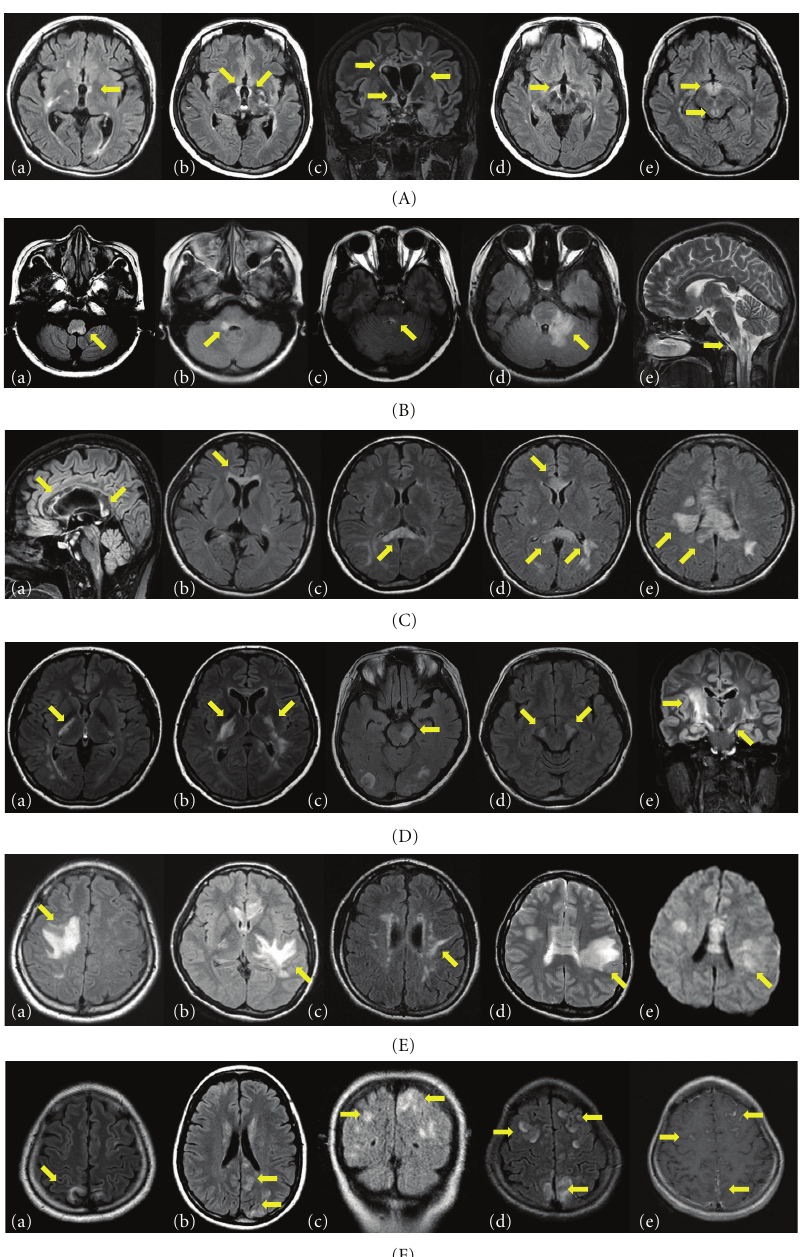
Figure 2: Characteristic brain abnormalities in neuromyelitis optica spectrum disorder (NMOSD) patients on T2-weighted or fluid- attenuated inversion recovery (FLAIR) MRI. (A) Periependymal lesions surrounding the third ventricle and cerebral aqueduct. These lesions can be unilateral (a) or bilateral (b) and sometime accompany with the periependymal lesions surrounding the lateral ventricles (c).